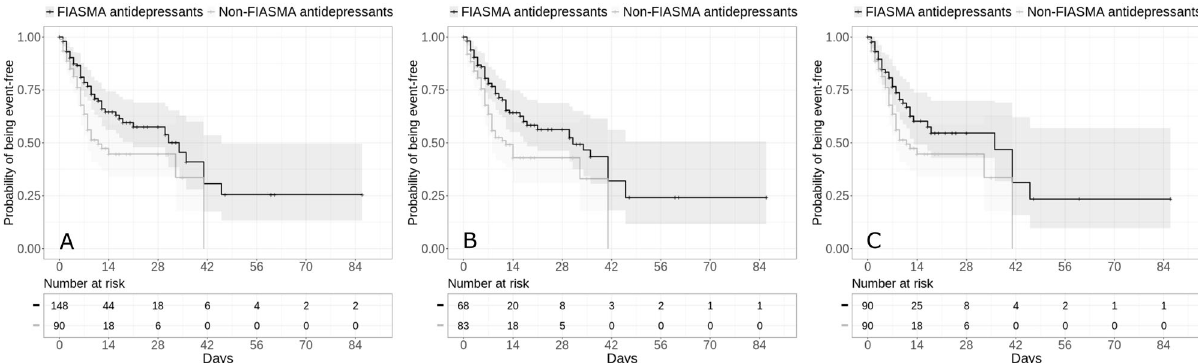
Fig. 3 Kaplan-Meier curves for the composite endpoint of intubation or death among patients with psychiatric disorders hospitalized for severe COVID-19 and receiving a FIASMA versus a non-FIASMA antidepressant at baseline. Kaplan – Meier curves for the composite endpoint of intubation or death in the full sample crude analysis ( N = 238) ( A ), in the full sample analysis with IPW ( N = 238) ( B ), and in the matched analytic sample using a 1:1 ratio ( N = 180) ( C ) among patients with psychiatric disorders hospitalized for severe COVID-19 and receiving a FIASMA versus a non-FIASMA antidepressant at